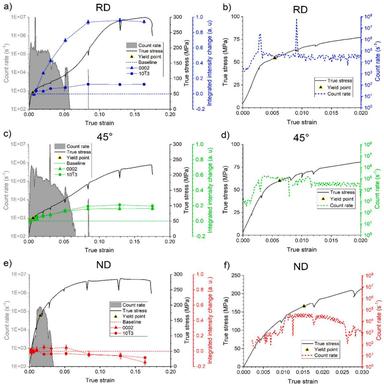
Deformation curves together with the evolution of the AE count rate, and integrated intensity changes of selected diffraction peaks for the a) RD, c) 45° and e) ND samples. The detailed values of flow stress and AE count rate in the vicinity of the macroscopic yield for the b) RD, d) 45°, and f) ND samples.